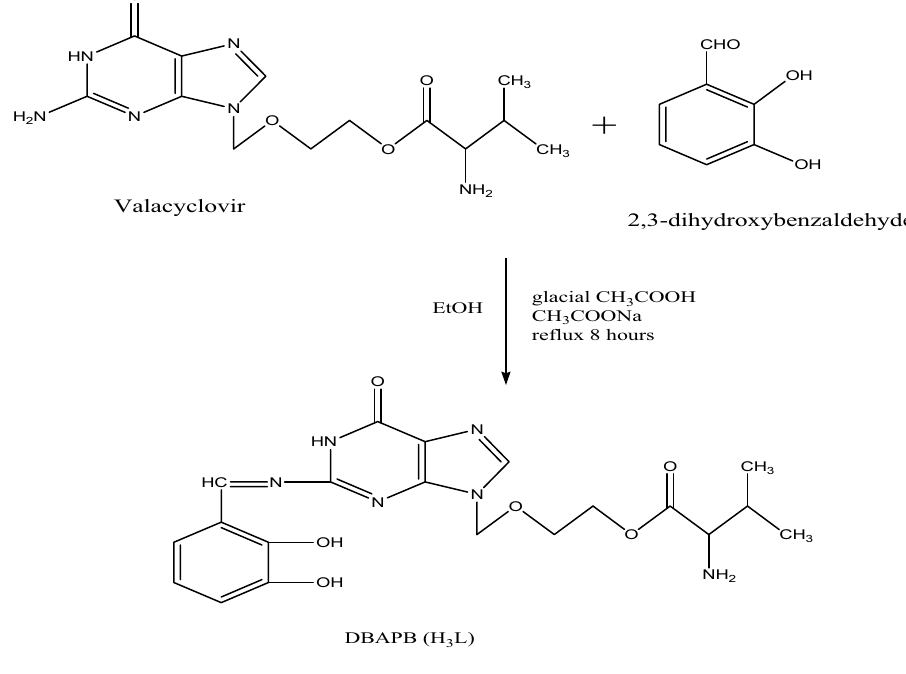
Figure 1. Synthesis of the Schiff base ligand, DBAPB.